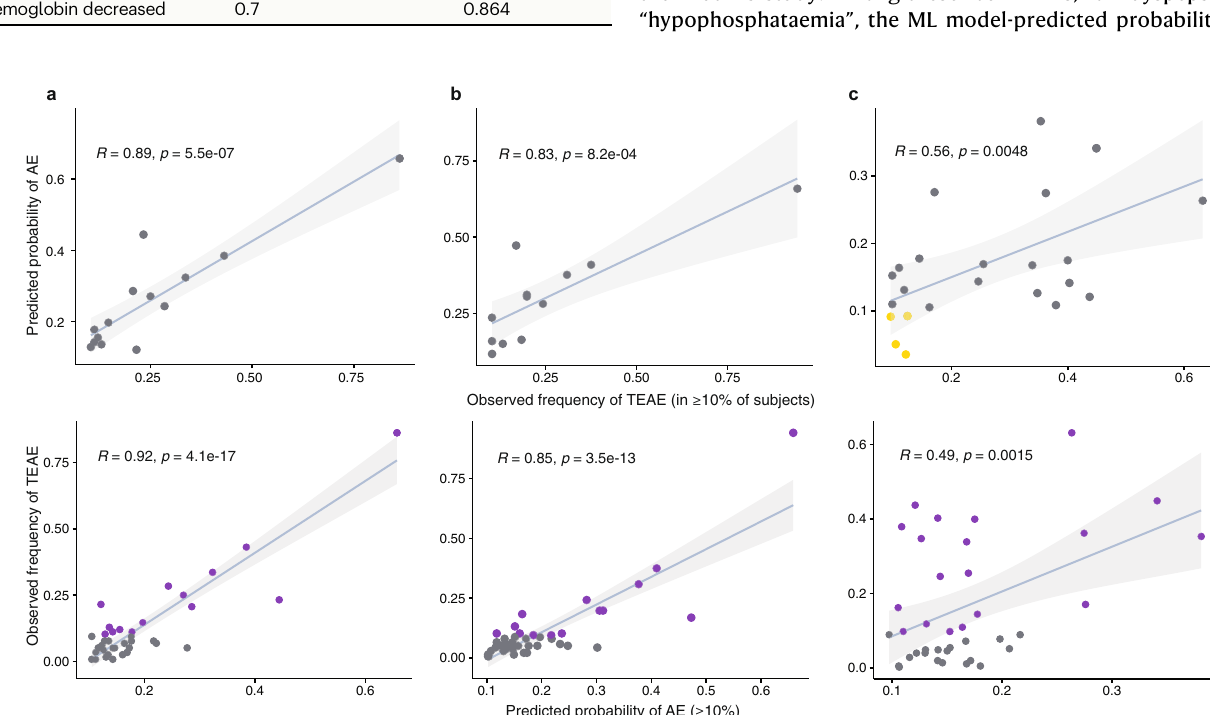
Fig. 3 | External validation on independent SMKI datasets: relationships betweenthemodelpredictedAEprobabilitiesandtheobservedAEincidences. Columns a – c are results based on two neratinib and one imatinib studies, respectively. The top panels show the scatterplots for the corresponding pre- dicted probabilities vs all the frequently reported TEAEs (in ≥ 10% of study subjects) and the bottom panels for the corresponding observed TEAEs vs all